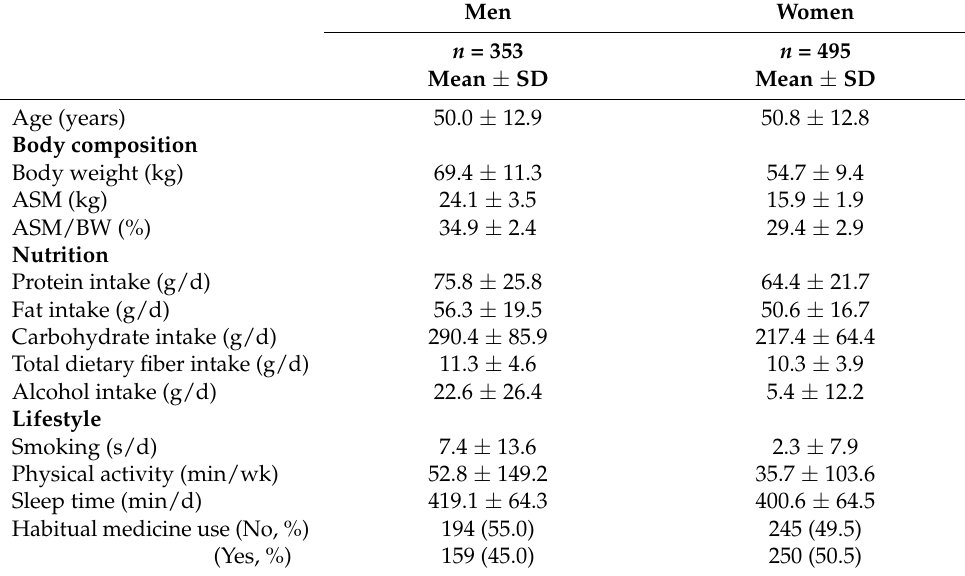
Table 1. Characteristics of the study